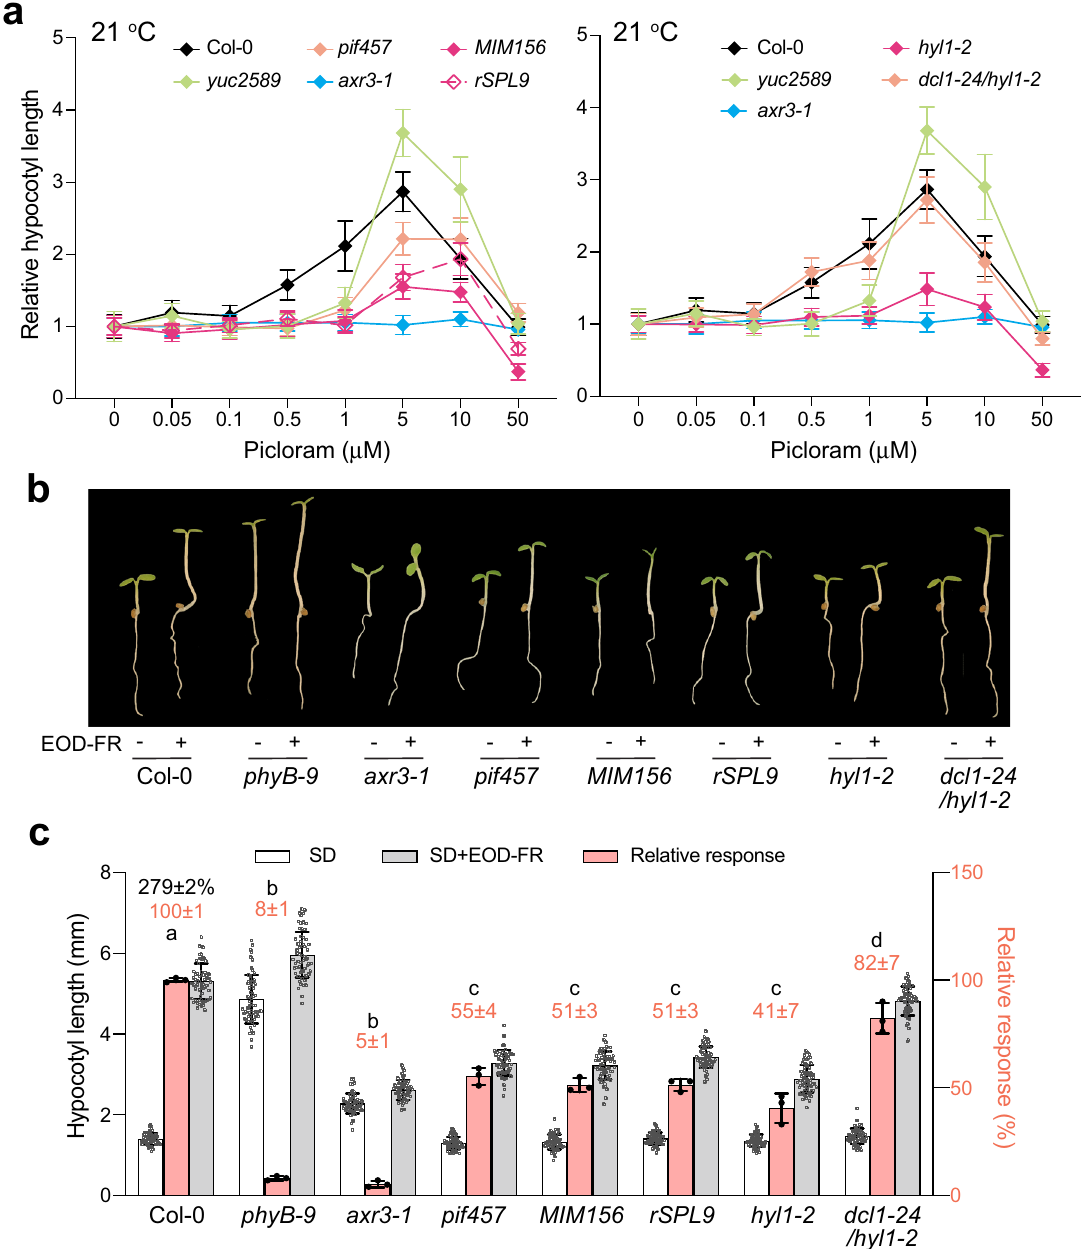
Fig.6|MiR156-dependentauxinsensitivityisrequiredfortheshadeavoidance response.a AuxindosageresponsecurvesshowingthatmiR156isrequiredforthe hypocotyl ’ sresponsivenesstoauxinat21°C.Hypocotyllengthmeasurementsof4- d-old Col-0, yuc2589 , axr3-1 , pif457 , MIM156 , rSPL9 , hyl1-2 , and dcl1-24/hyl1-2 seed- lings grown under 50 μ molm − 2 s − 1 R light at21°C and treated with a concentration seriesofpicloramfrom0to50 μ M.Hypocotyllengthwascalculatedrelativetothat without picloram treatment foreachgenotype. Error bars represent the s.d., n = at least30seedlings.Thecentersoftheerrorbarsindicatethemean. b Imagesof4-d- old Col-0, phyB-9 , axr3-1 , pif457 , MIM156 , rSPL9 , hyl1-2 , and dcl1-24/hyl1-2 seedlings grown at 21°C under the short-day condition of 8h of 100 μ mol m − 2 s − 1 white light and 16h of dark with or without a 15min end-of-day FR (EOD-FR) light